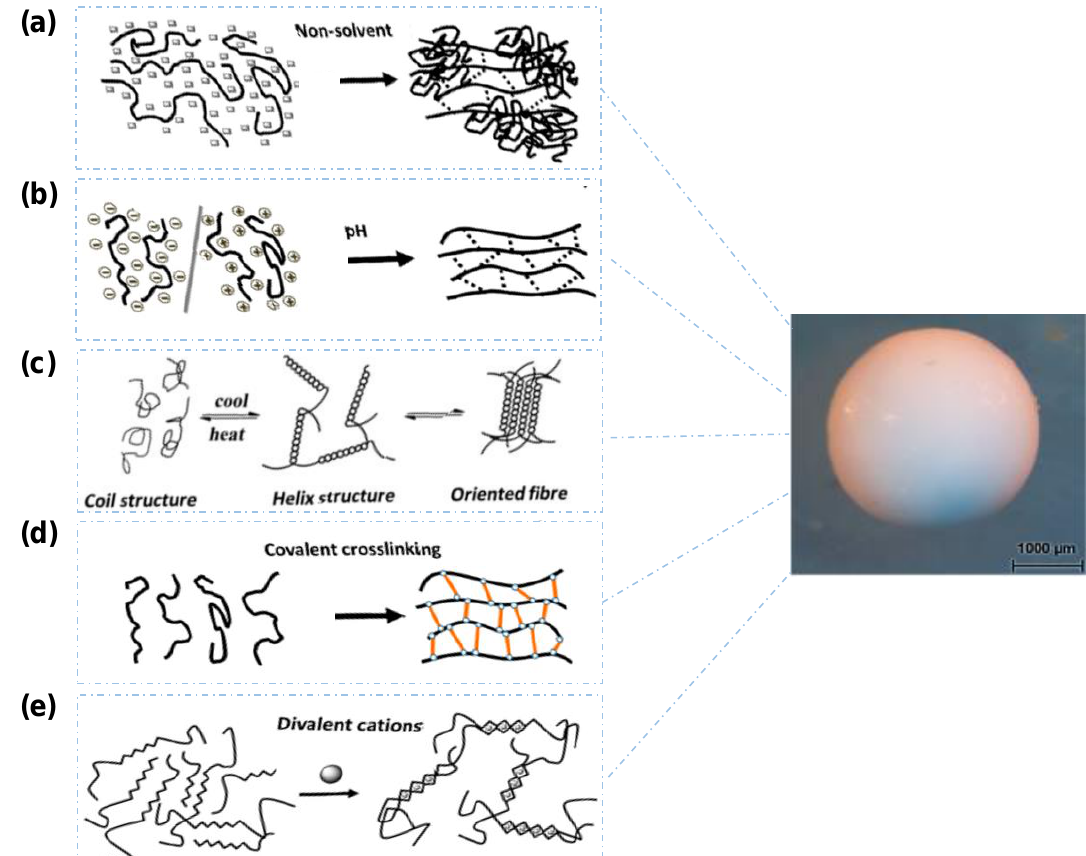
Figure 6. Illustration of the main mechanisms to induce SOL-GEL transition of polysaccharide droplets: ( a ) non-solvent approach to produce a non-solvent filled gel network, ( b ) pH-induced gelation, ( c ) temperature-induced (thermotropic) gelation in which the polysaccharides undergo structural transition from coil to helix and then to double helix, ( d ) covalent crosslinking approach in which the polysaccharide chains are covalently crosslinked to form gel network and ( e ) ions-induced (ionotropic) gelation in which the polysaccharide molecules are crosslinked by ions. Reprinted (with some modifications) from [4] . Copyright (2018) Ganesan, Budtova, Ratke, Gurikov, Baudron, Preibisch, Niemeyer, Smirnova, Milow.